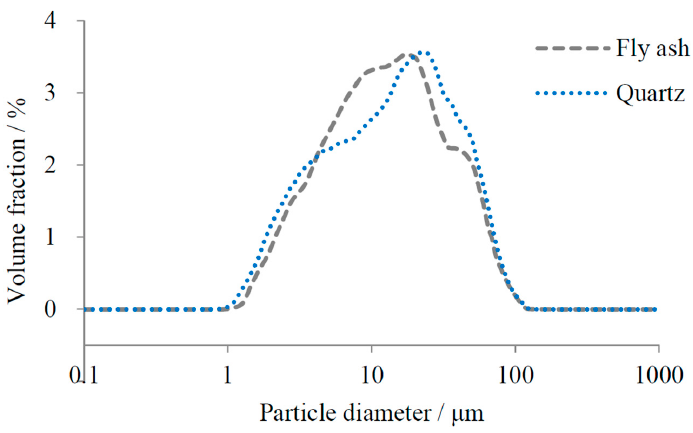
Figure 1. Particle size distribution of FA and quartz.